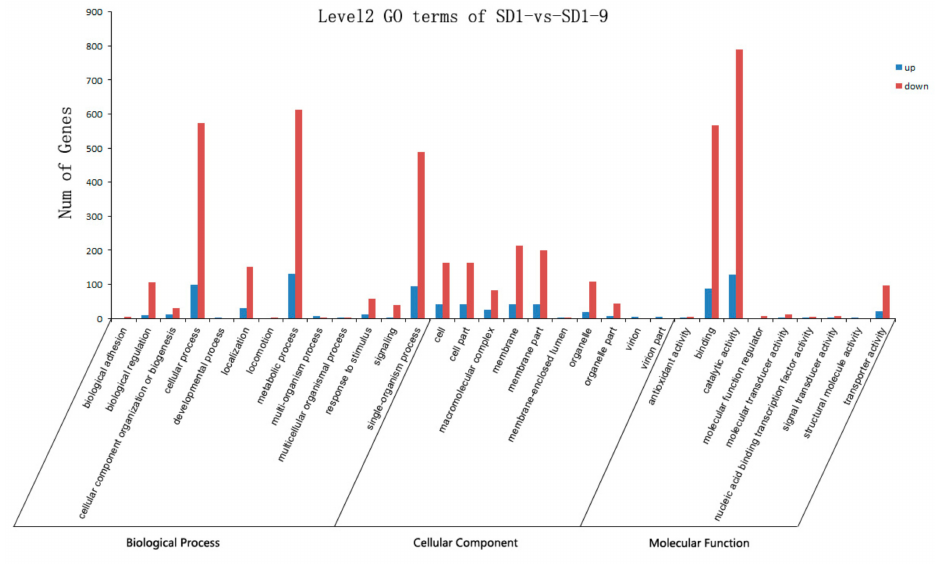
Figure 6. Gene Ontology (GO) enrichment analysis for di ff erentially expressed gene (DEG).